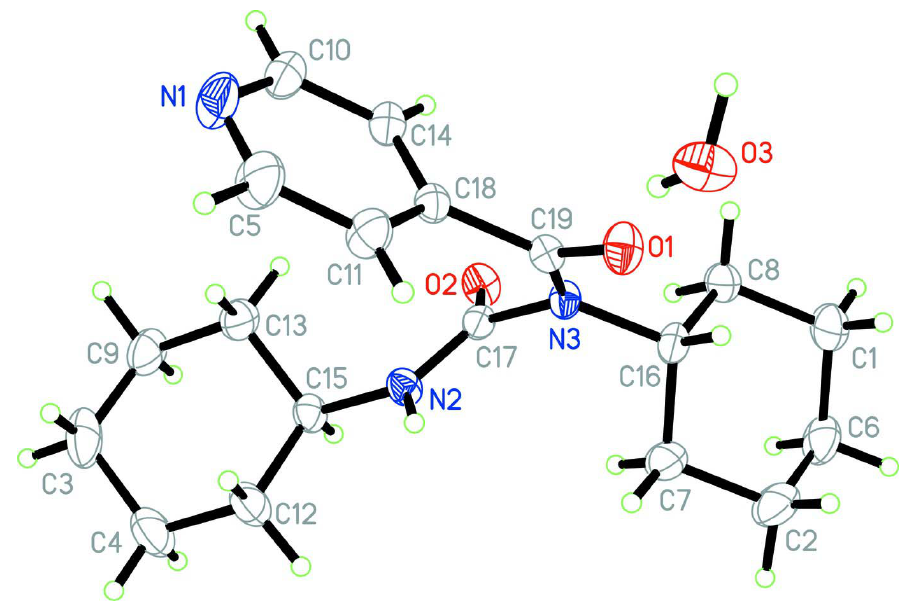
Figure 1 Perspective view of the title complex with the atom-numbering scheme. Atomic displacement ellipsoids are shown at the 30% probability level.